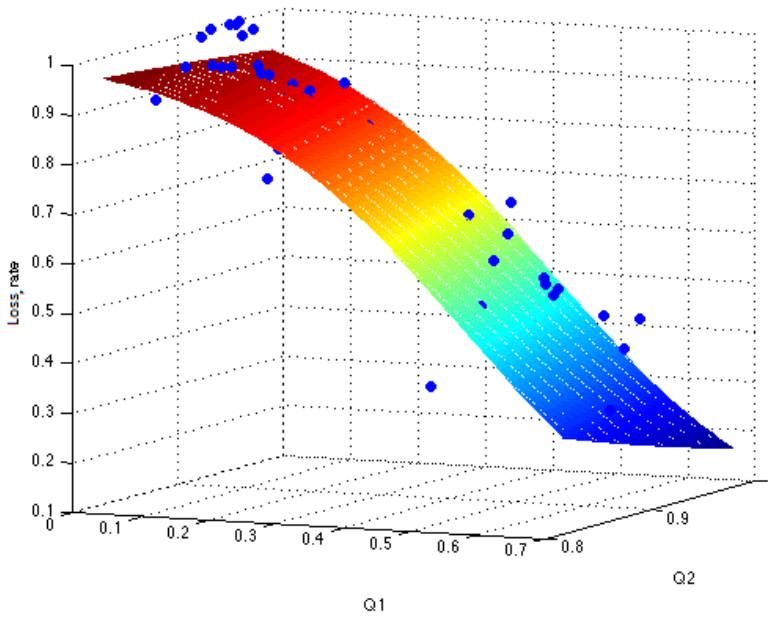
Figure 7: Plot of the logistic regression model and of the data obtained by the simulation of n = 50 portfolios.